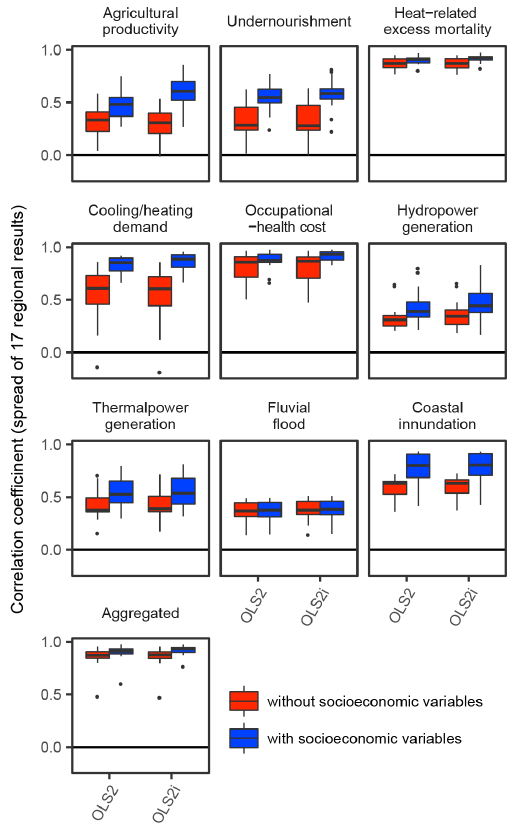
Figure 3. Performance of emulations in comparison 2. Correlation coefficients between simulation results and emulation results are